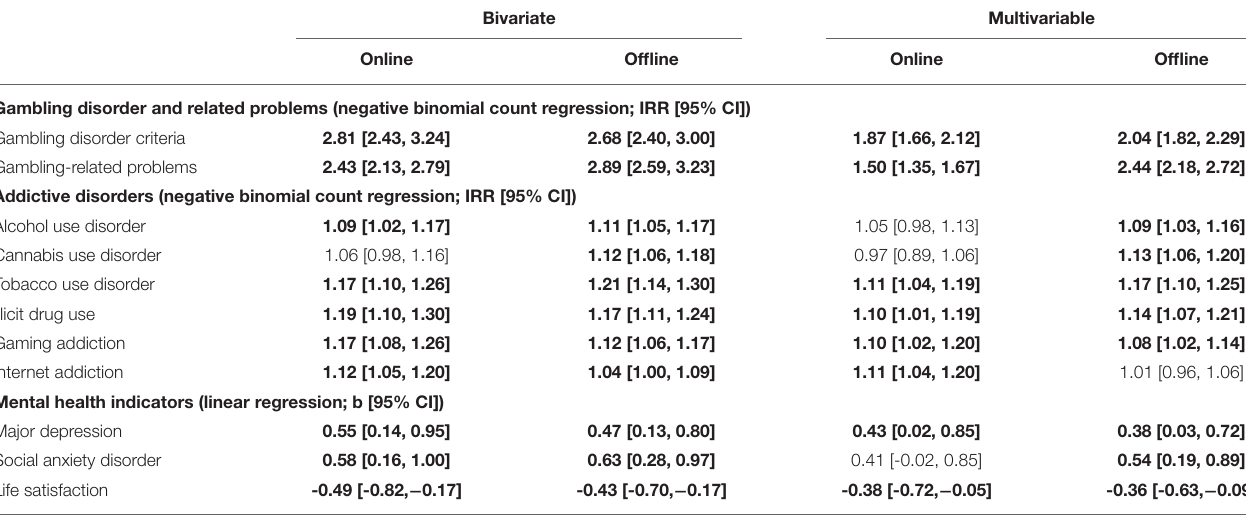
TABLE 3 | Negative binomial regression (IRR [95% CI]) on gambling disorder symptoms, gambling problems, other addictive disorders and mental health variables by money (per CHF 100) gambled online and